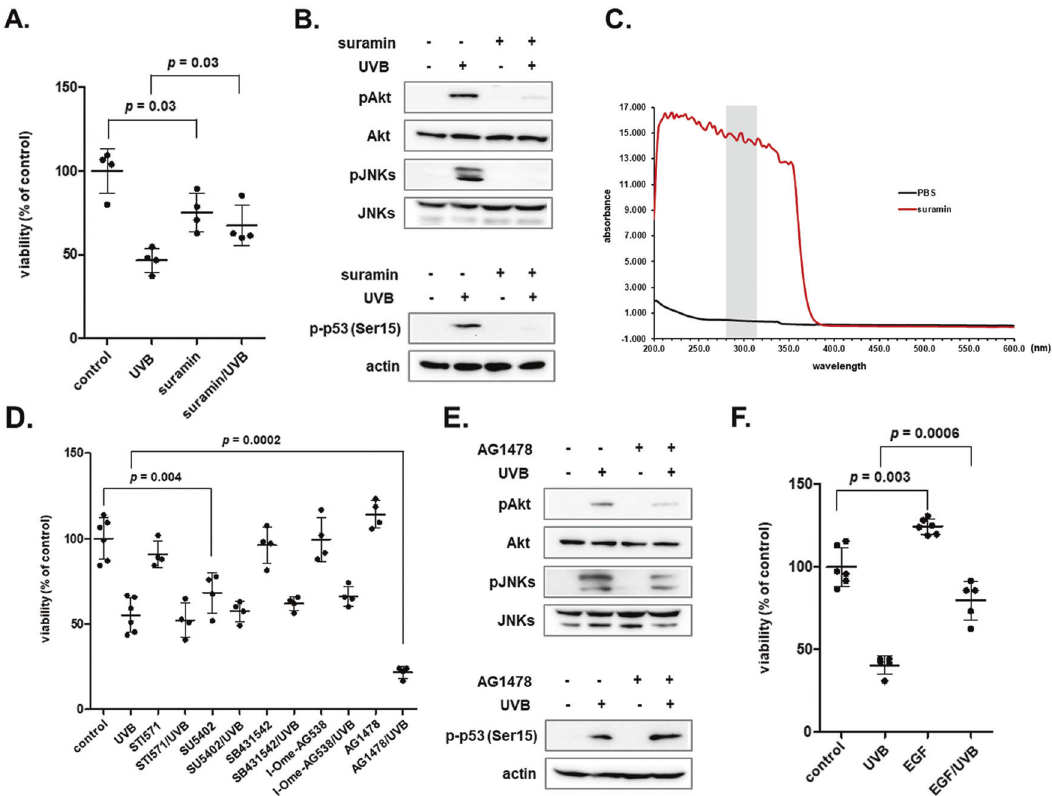
Fig. 4 UVB-induced cellular responses are EGFR-Akt mediated in human skin fi broblasts. A Human dermal fi broblasts were pre-incubated with 100 μ M suramin for 1 h before exposure to 700 mJ/cm 2 of UVB radiation. Then, cells were further incubated at 37 o C for 72 h and cell number was counted after staining with Neutral Red. A representative experiment out of three similar ones is shown. p for statistically signi fi cant differences in comparison to the respective samples in the absence of suramin (Student ’ s t test) is presented in the graph. B